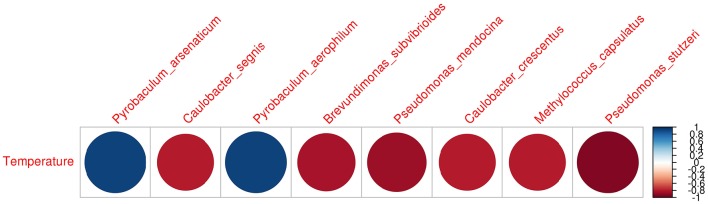
Spearman's Rank correlation of species with temperature. Species proportions obtained from metagenomic analysis were correlated with temperature and those with significant Spearman's Rank correlation coefficient (FDR adjusted p ≤ 0.05) and higher correlations (ρ ≥ 0.7; ρ ≤ −0.7) were plotted.